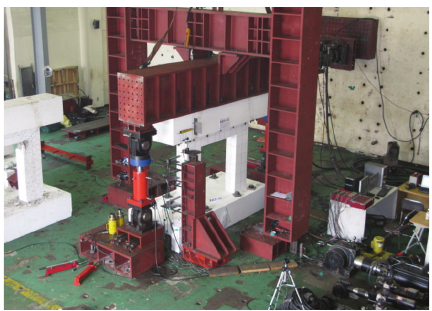
Figure 9: Cracks that appeared in the CL-F specimen during cyclic loading.